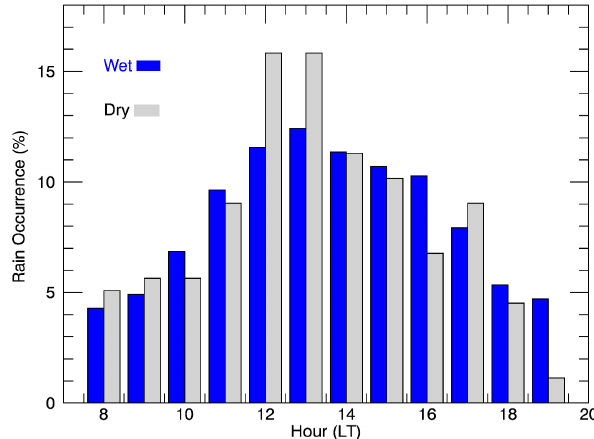
Figure 9. Normalized hourly rainfall occurrence distribution ob- served over T3 for the wet and dry seasons (NR–RR days